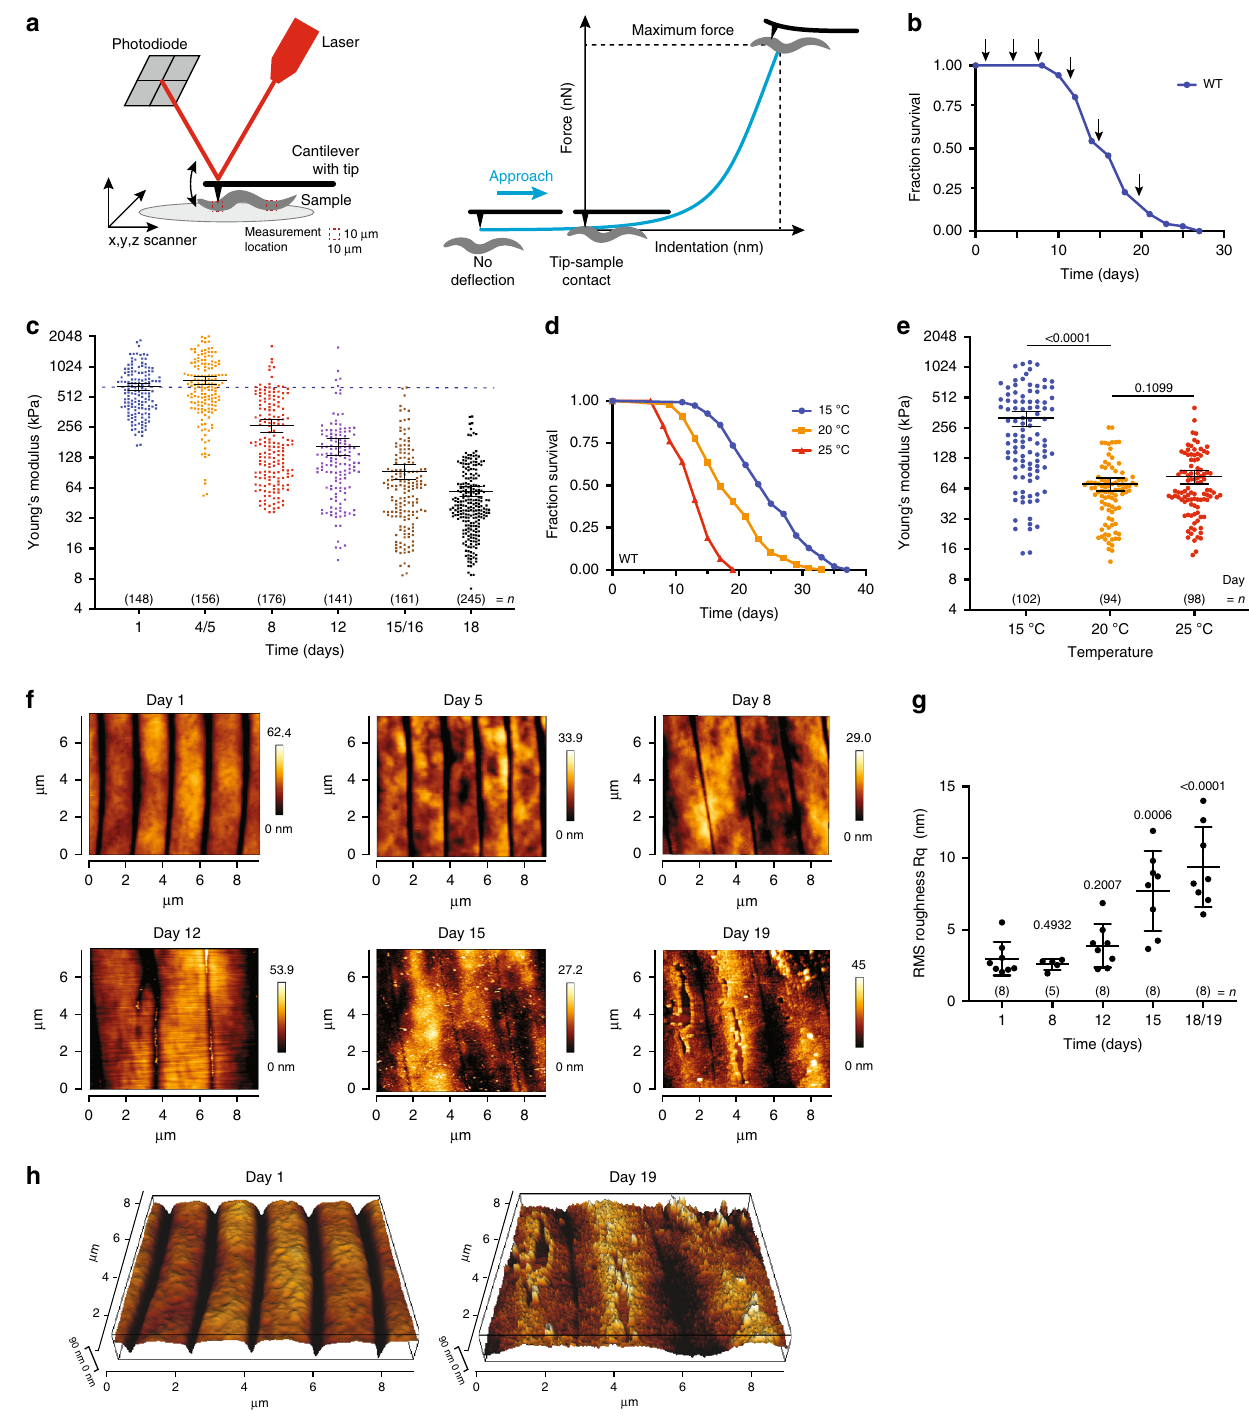
increase of daf - 2;daf - 16 vs daf - 16 , log rank p = 0.6554; cox pro- portional hazards (CPH) < 0.001 for the interaction of terms: daf - 2 and daf - 16 Fig. 2a, Supplementary Data 2). Stiffness did not differ between daf - 2 mutant worms and day 1 wild-type worms (FC = 1.08, t test p = 0.3605, Fig. 2b, Supplementary Data